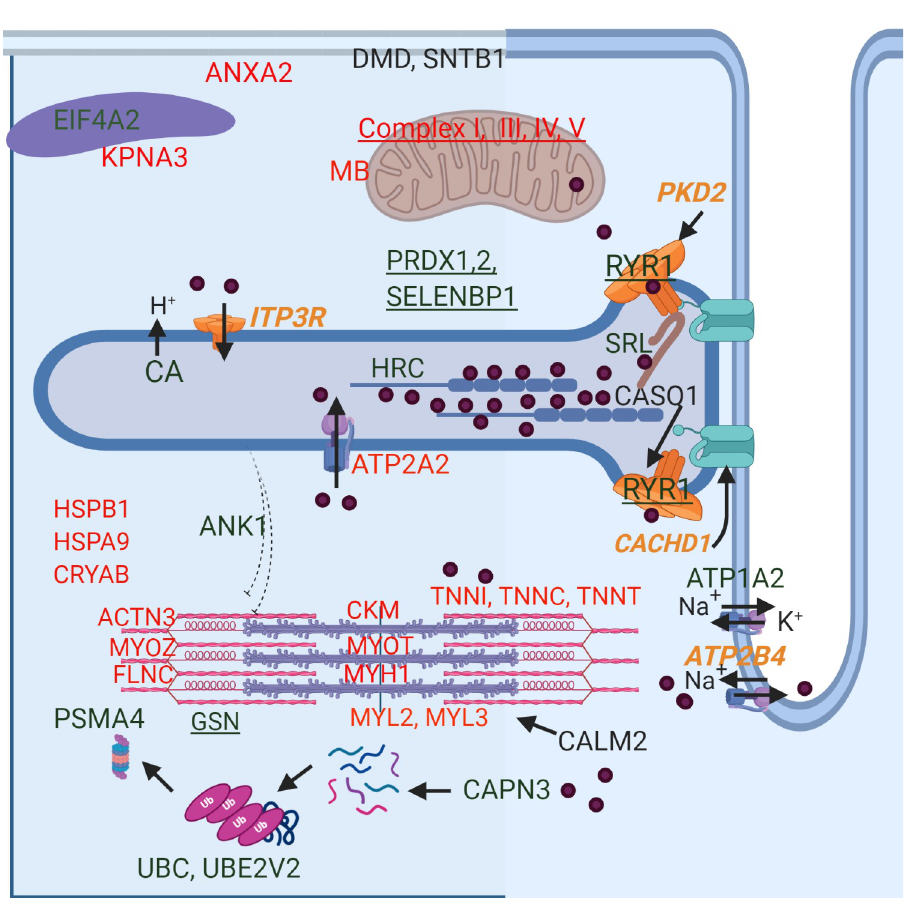
Fig 1. Depiction of the cellular location of differentially expressed proteins and select differentially expressed genes in RER-susceptible horses. Increased expression is in green and decreased expression in red. Proteins that also had differential expression of their encoding gene are underlined. Differentially expressed genes ( italics ) relating to Ca 2 + regulation are shown in orange. Ca 2+ is depicted by purple circles. Full names of genes and proteins are found in Tables 2–4. RER-susceptible horses between episodes of rhabdomyolysis had increased expression of ANK1, which links sarcoplasmic reticulum to myofilaments, Ca 2+ binding proteins within the sarcoplasmic reticulum (CASQ1, SRL, HRC), the Ca 2+ release channels ITP3R and RYR1, as well as regulators of RYR1 [calmodulin (CALM2), calsequestrin (CASQ1), PKD2 , and CACHD1 (via DHPR)]. Proteins involved in oxidative stress (PRDX1, PRDX2, SELENBP1) and protein degradation [Ca 2+ -activated calpain (CAPN3), ubiquitination (UBC, UBE2V2), proteasome (PSMA4)] were differentially expressed. Decreased expression was found for Ca 2+ activated proteins [SERCA2 ( ATP2A2) , troponins (TNN1,C,T) myosin regulatory light chains (MYL2,3)] as well as other sarcomere proteins (ACTN3, MYOZ, FLNC, MYH1). Heat shock proteins (HSPB1, HSPA9) and protein chaperones had decreased expression in RER. Decreased expression was found for mitochondrial proteins myoglobin (MB), 6 subunits of complex I, 3 subunits of complex III, 4 subunits of complex IV and 4 subunits of complex V. ANXA2, a Ca 2+ activated membrane repair protein was also downregulated and sarcolemmal structural proteins dystrophin (DMD) and syntrophin (SNTB1) were upregulated. The sodium/potassium exchanger (ATP1A2) and the sodium/ Ca 2+ exchanger ATP2B4 , were also differentially